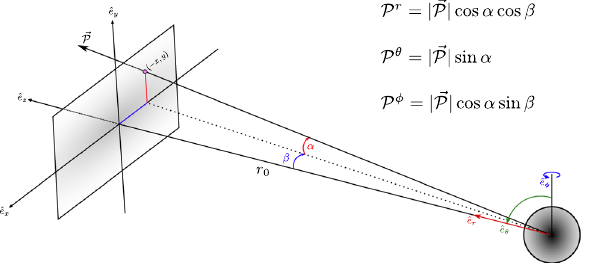
Fig. 2 Illustration of the image plane associated with an inertial observer at a distance r 0 from the black hole. The final position of the photons is characterized by the spatial part of four-momentum P measured by the observer (the temporal component is irrelevant since it does not influence the trajectory of the photons), whose origin is taken in the center of the black hole. The impact parameters are related to α and β , where α is the angle between P and its projection in the plane xz , and β corresponds to the angle between this projection and r 0 . Also, the observer is located such that the radial direction coincides with the z -axis, where it is clear that ˆ e x = ˆ e φ and ˆ e y = −ˆ e